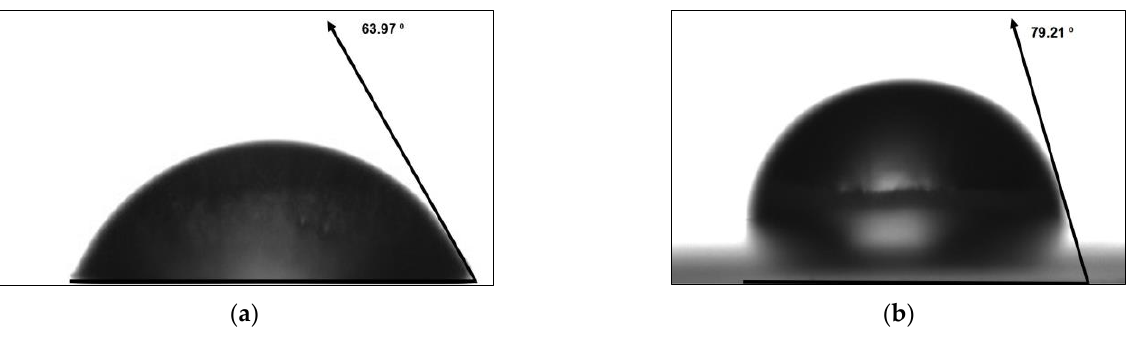
Figure 6. The contact angle of water droplets on starch-based films: ( a ) corn starch; ( b ) hydrolyzed corn starch.